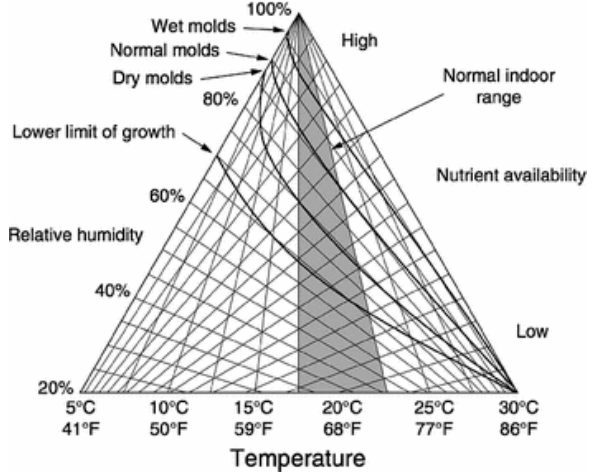
Figure 1. Growth conditions for mould [19,20].